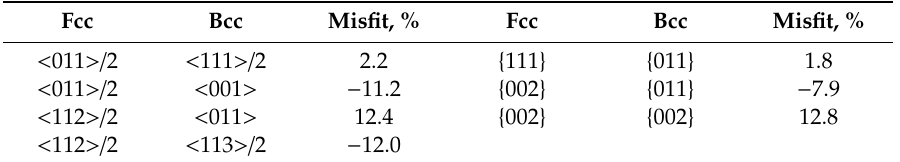
Table 1. Matched atomic rows or reciprocal rows between the face centered cubic (fcc) lattice and body centered cubic (bcc) lattice, where the distance for the atomic row is smaller than 2a f (or 0.8 Å − 1 for reciprocal vectors), the reciprocal rows are (near) closely packed planes, and the misfit criterion is 15%.